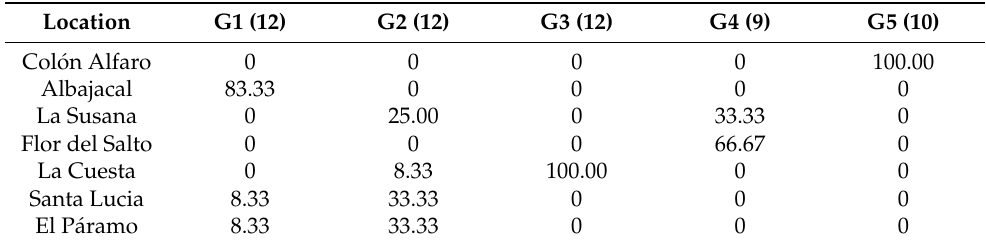
Table 6. Locations of farms of small producers of Jipijapa pigs in each identified group (% over the total of farms in the group). In brackets is the number of